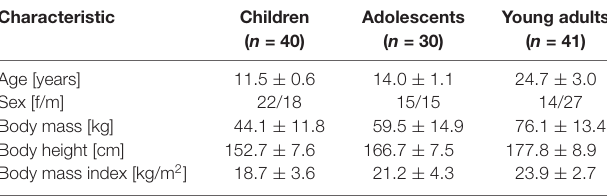
TABLE 1 | Characteristics of the study participants ( N = 111) by age